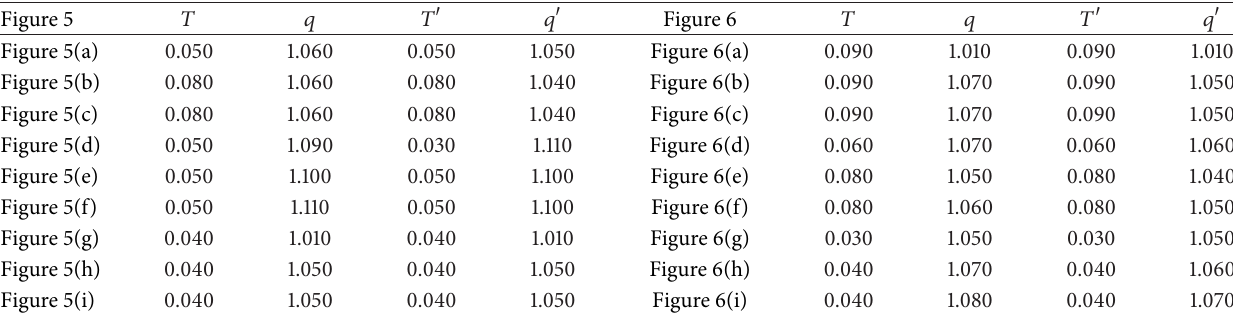
Table 3: Values of 𝑇 , 𝑞 , 𝑇 󸀠 , and 𝑞 󸀠 taken in Figures 5 and